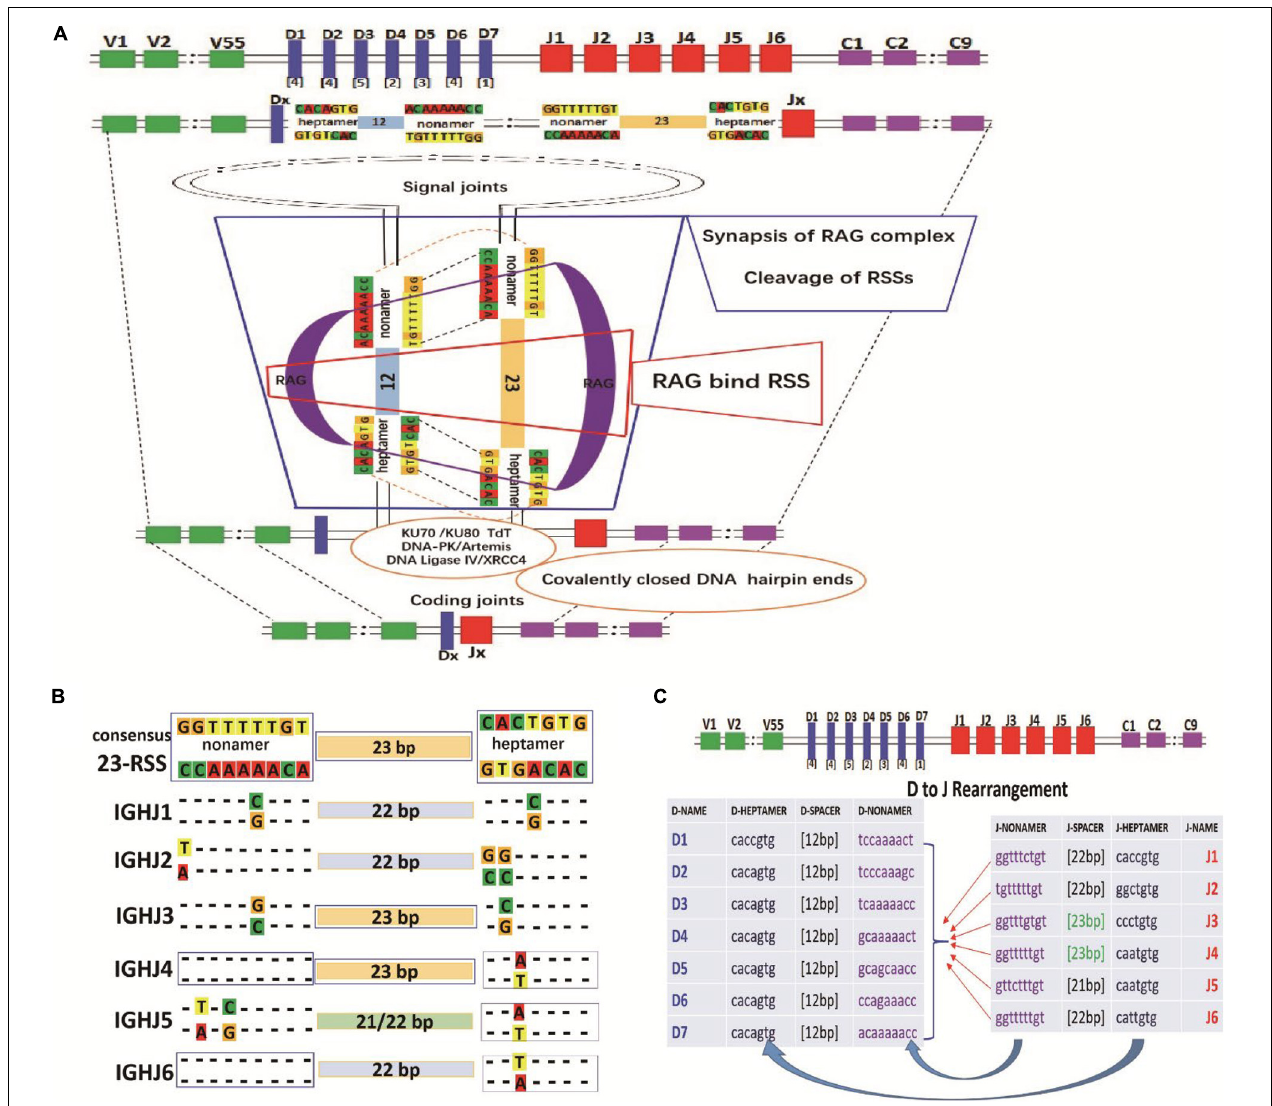
FIGURE 5 | RSS composition characteristics during the IGHD-IGHJ recombination. (A) The schematic diagram of IGHJ and IGHD recombination. (B) The composition characteristics of human 9-23-7 RSSs (IGHJ-non-amer–IGHJ- spacer–IGHJ-heptamer). (C) The pairing of IGHJ (7-12-9) RSSs and IGHD (9-23-7) RSSs during the IGHD-IGHJ